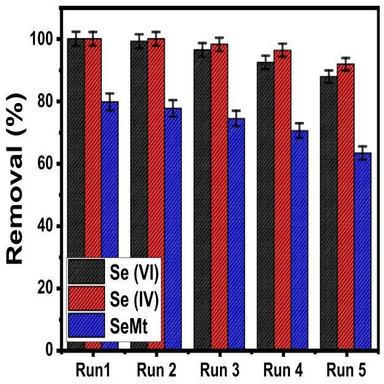
The recyclability properties of CF/ZA composite during the removal of the different selenium species.